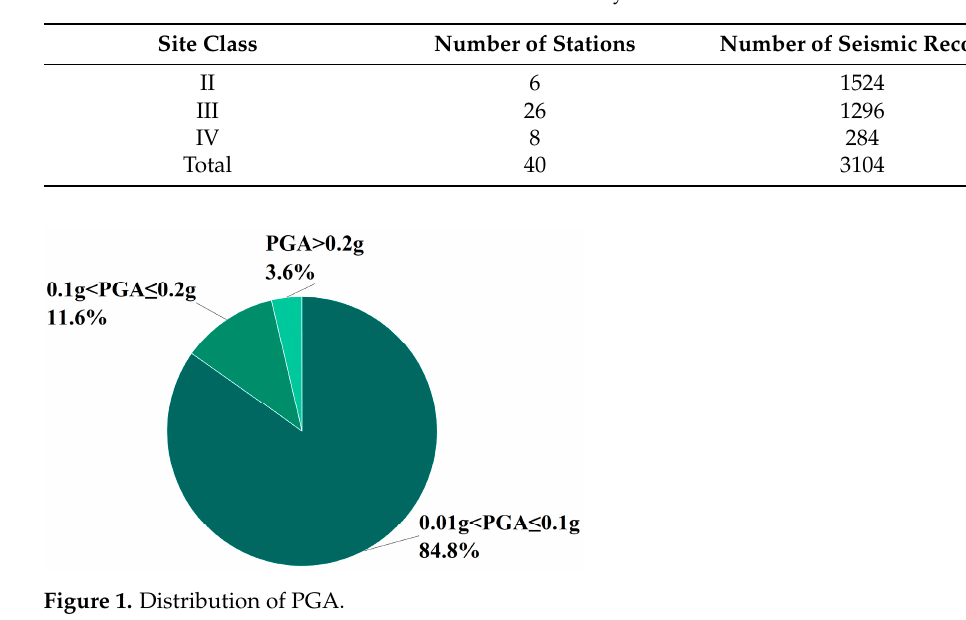
Table 2. Number of stations and records of seismic activity at various sites.